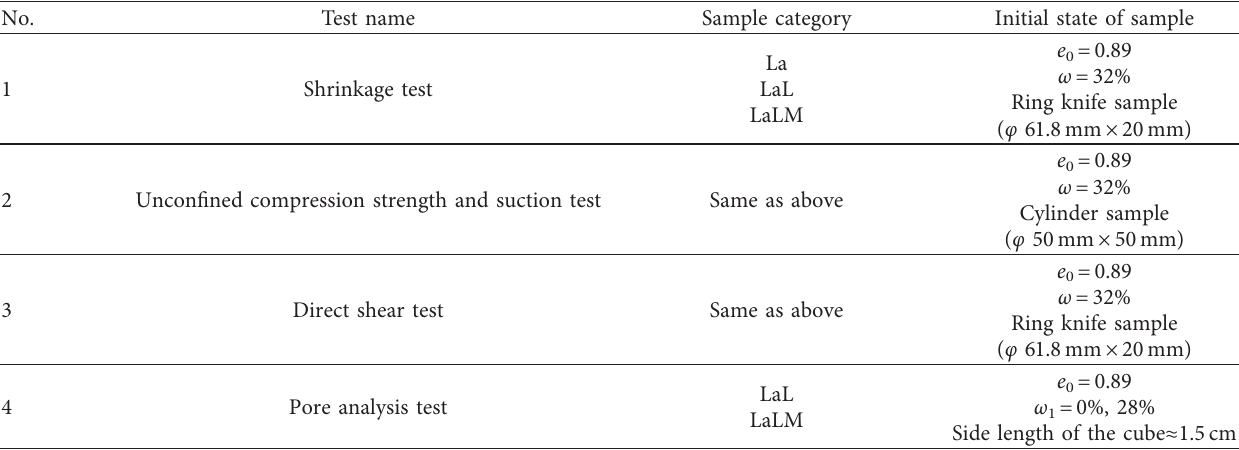
Table 3: Testing plan.